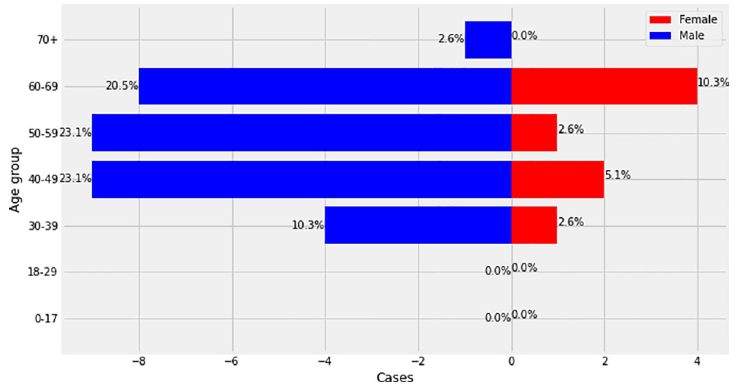
Fig 3. Age/sex pyramid (severe